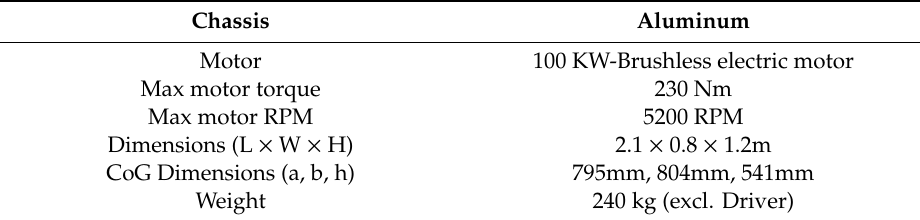
Figure 2. Front swingarm assembly: ( a ) top view; ( b ) side view. Table 3. Testbed vehicle (Daedalus) technical specifications.